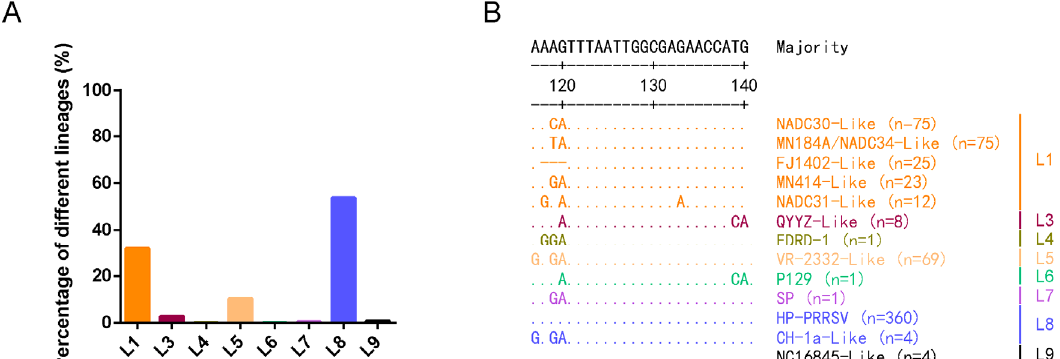
Figure 5. The proportion and mutations in the 3 ′ -UTR motif of different PRRSV lineages. ( A ) The proportion of differential lineage PRRSVs based on all available full-length sequences of PRRSV-2 strains ( n = 765) in 1991–2019. ( B ) Different mutation patterns of 117–120th of 3 ′ -UTR in different lineage PRRSVs. The representative strain of each lineage, together with the amount of PRRSV strains in corresponding mutation patterns, was listed on the right side of the sequences. Table 2. Mutations of the 117–120th motif in different PRRSV lineages. L1 includes five mutation patterns: AATA (represented by MN184A), AACA (represented by NADC30), AAGA, AGAA and deletion at position 118–120th. L3 includes two mutation patterns: AAAA and AAGA. L8 includes five dominant mutation patterns: AAAG (represented by HuN4), AAAA, TAAG, AGAG and GAGA (represented by CH-1a).